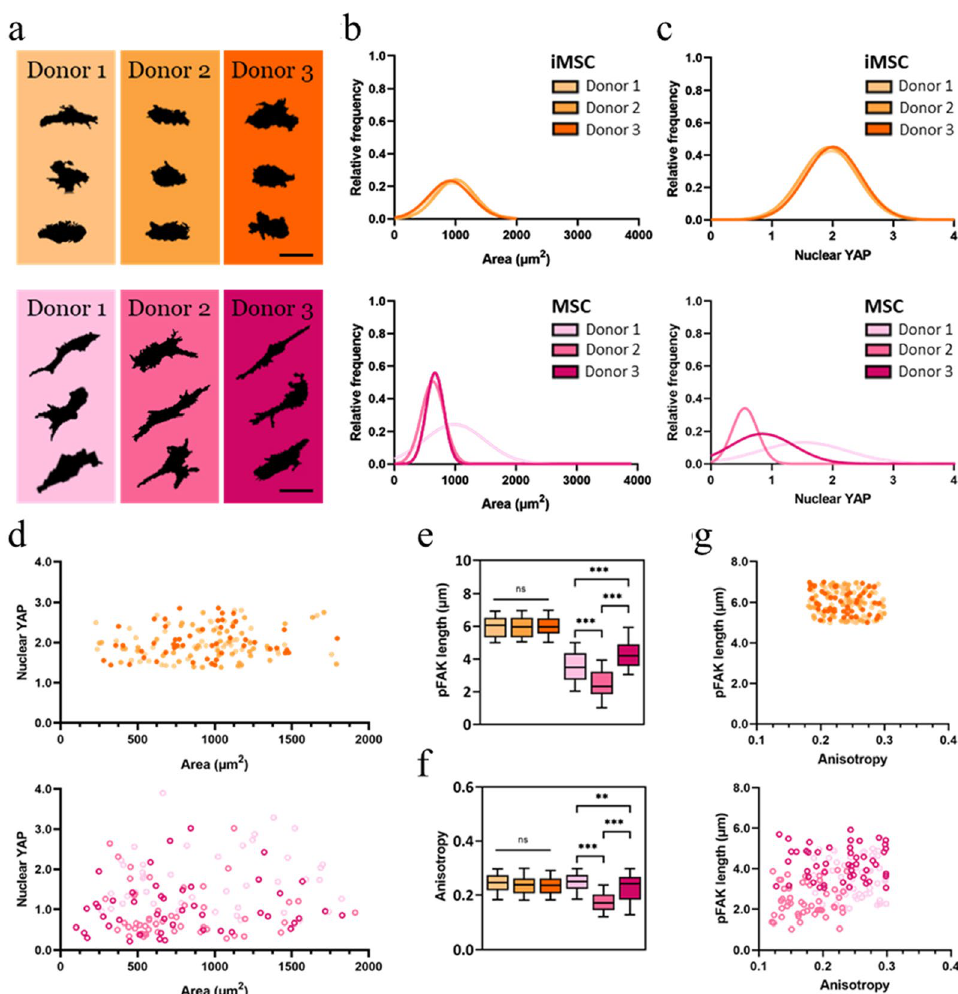
Figure 4. Morphological and cellular mechanosensing comparison between iMSCs and MSCs on Med stiffness hydrogels. ( a ) Representative cell silhouettes of 3 iMSC (top) and MSC (bottom) cell lines. Histograms of ( b ) cell area and ( c ) nuclear YAP of 3 iMSC (top) and MSC (bottom) cell lines. ( d ) Nuclear YAP versus area scatter plot of 3 iMSC (top) and MSC (bottom) cell lines. Whisker plots of ( e ) pFAK length and ( f ) actin anisotropy of iMSC (3 left whisker plots) and MSC (right whisker plots) cell lines. ( g ) Scatter plots of pFAK length versus actin anisotropy of 3 iMSC (top) and MSC (bottom) cell lines. Scale bars: 50 µm. Box plots show 25/50/75th percentiles, whiskers show minimum/maximum; n > 50 cells per group, *p < 0.05, **p < 0.01, ***p < 0.001, n.s. not